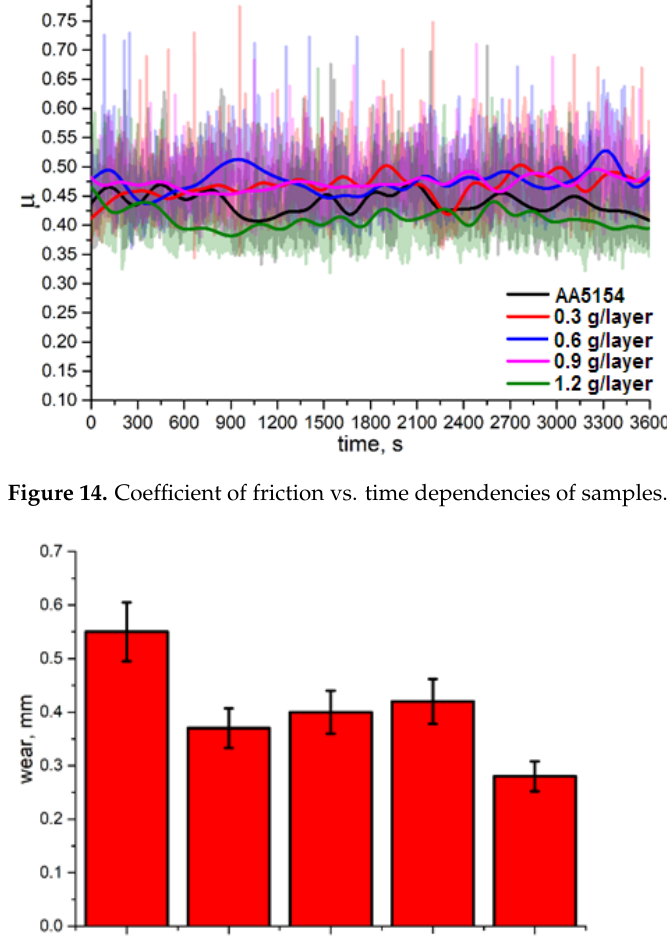
Figure 15. Wear of the composite layers obtained.